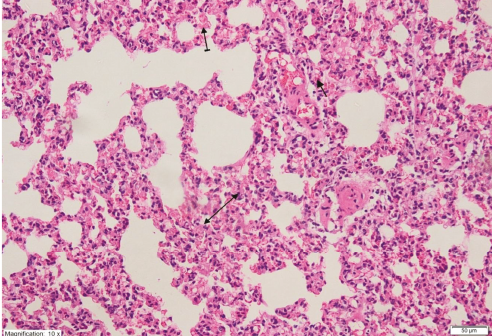
Figure 6: Extensive alveolar septal fi brosis (double-sided arrow), in fi ltration of polymorphic nuclear leucocytes (straight arrow), and haemorrhagic foci (dashed arrow) in the lung tissue of the CIS group (H&E ×